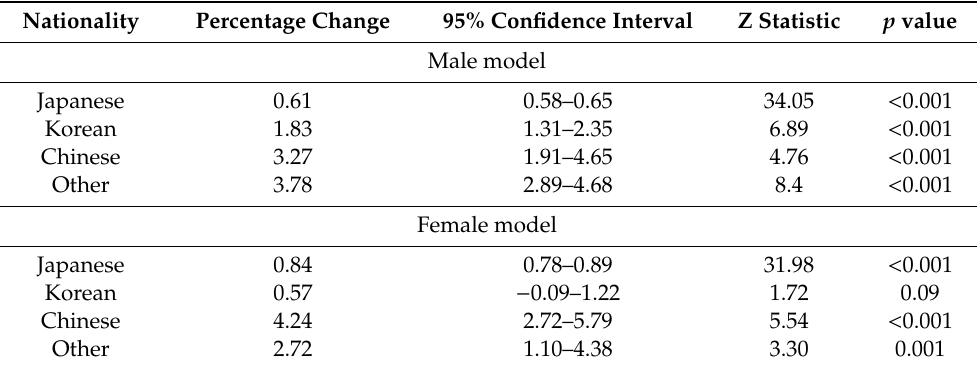
Table 3. Percentage change in mortality for a year’s increase in age by sex and